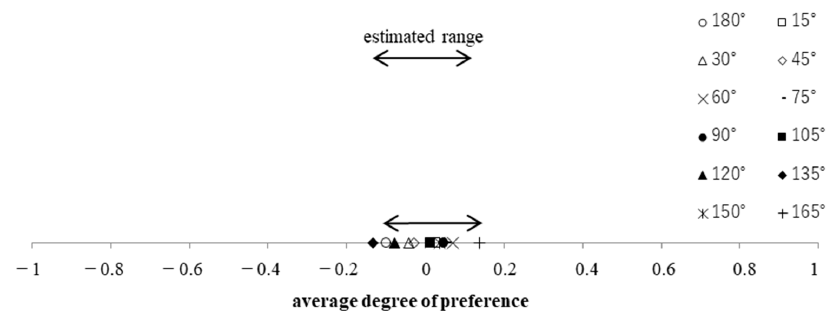
Figure 11. In terms of stripe angle brightness perception, angle 165° was the brightest result. There was no significant difference in stripe angles of 165°, 60°, 75°, 90°, 150°, 15°, 105°, 45°, 30°, 120°, and 180°.